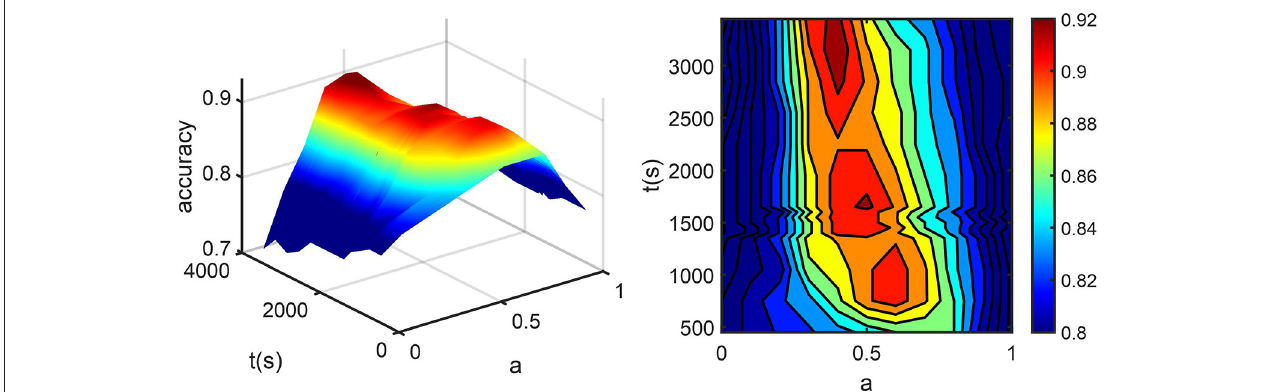
FIGURE 3 | (A) The percentage of correctly classified subjects (accuracy) vs. t2 and a. (B) accuracy was projected into the a-t plane. Here t1 is fixed at 1,650s for the convenience of display. The dark red part in the center corresponds to sets of parameters with maximum accuracy, among which the one with minimum scan time was